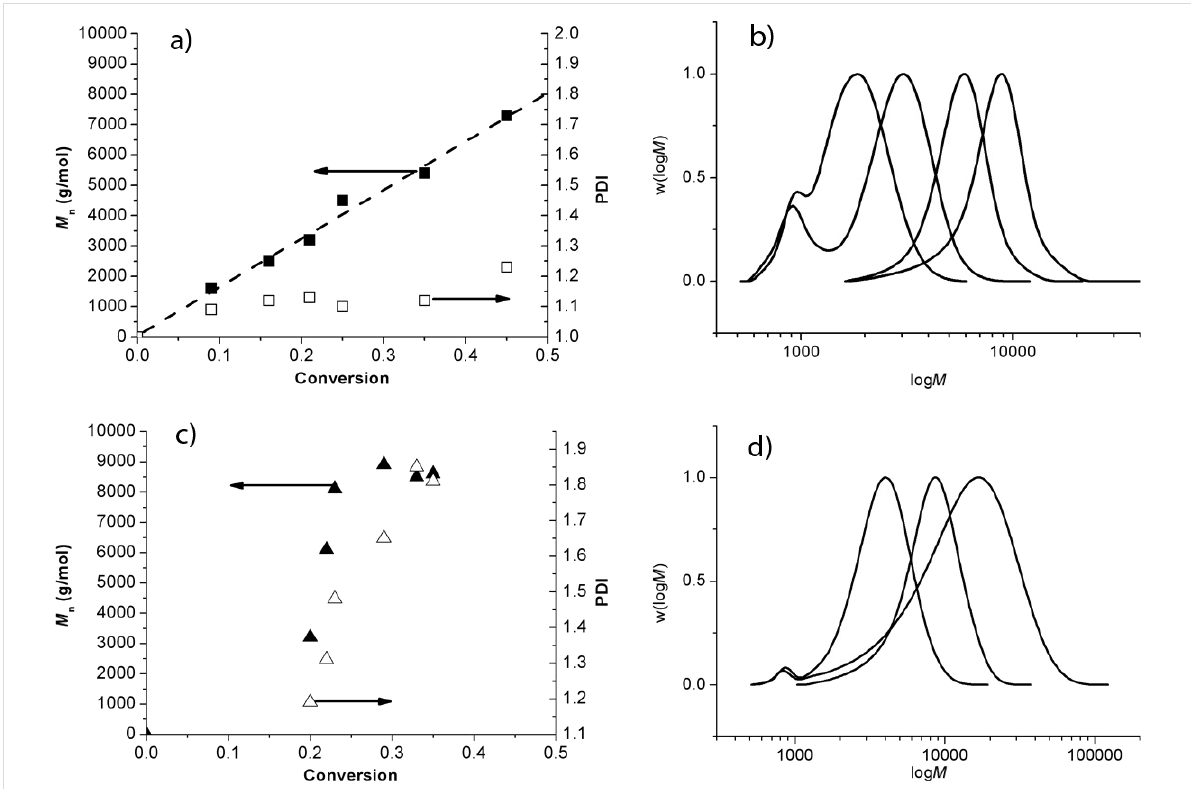
Figure 8: NMP of styrene initiated by the BlocBuilder MA alkoxyamine at 120 °C in DMA without LiCl salt. (a) Evolution of the number-average molar mass ( M n : filled symbols, linear fit: dash lines) and polydispersity indexes (PDI: empty symbols) with conversion. (b) Molar mass distribution (w(log M ) versus log M ) of the polystyrene chains at various conversions. NMP of styrene initiated by the BB alkoxyamine at 120 °C in DMA with 4.5 wt % of LiCl. (c) Evolution of the number-average molar mass ( M n : filled symbols) and polydispersity indexes (PDI: empty symbols) with conversion. (d) Molar mass distribution (w(logM) versus logM) of the polystyrene chains at various